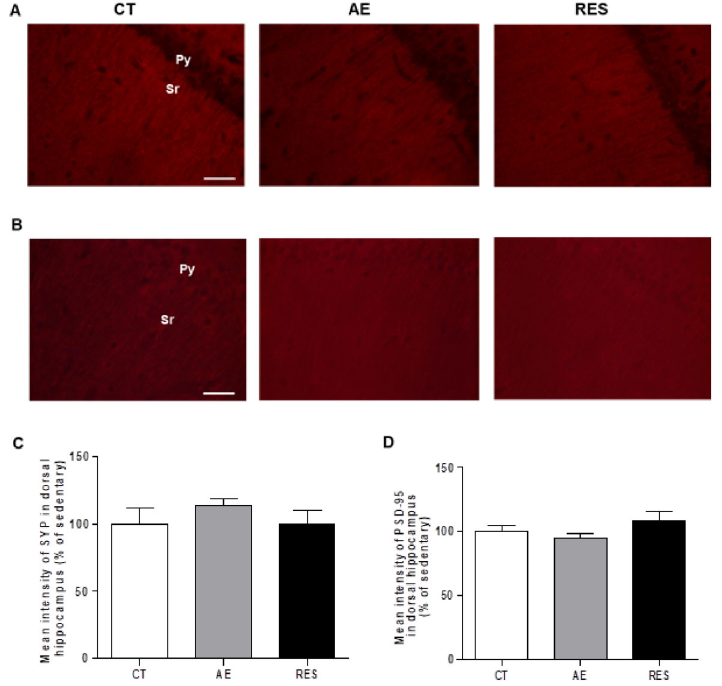
Figure 5. Analysis of neuroplasticity markers in the dorsal hippocampus. Photomicrographs of stratum radiatum stained for SYP ( A ) and PSD-95 ( B ) in the dorsal cornus ammonis 1 region (400 (cid:1) magni fi cation, scale bar=50 m m). Quanti fi cation of the immuno fl uorescence relative intensity (% of sedentary control) for SYP ( C ) and PSD-95 ( D ). One-way ANOVA followed by Tukey ’ s post hoc . Data are reported as means ± SE (n=4 – 6 per group). SYP: synaptophysin; PSD-95: postsynaptic density protein 95; Sr: stratum radiatum ; Py: pyramidal cells layer; CT: sedentary control; AE: aerobic exercise on the treadmill; RES: resistance exercise on the ladder